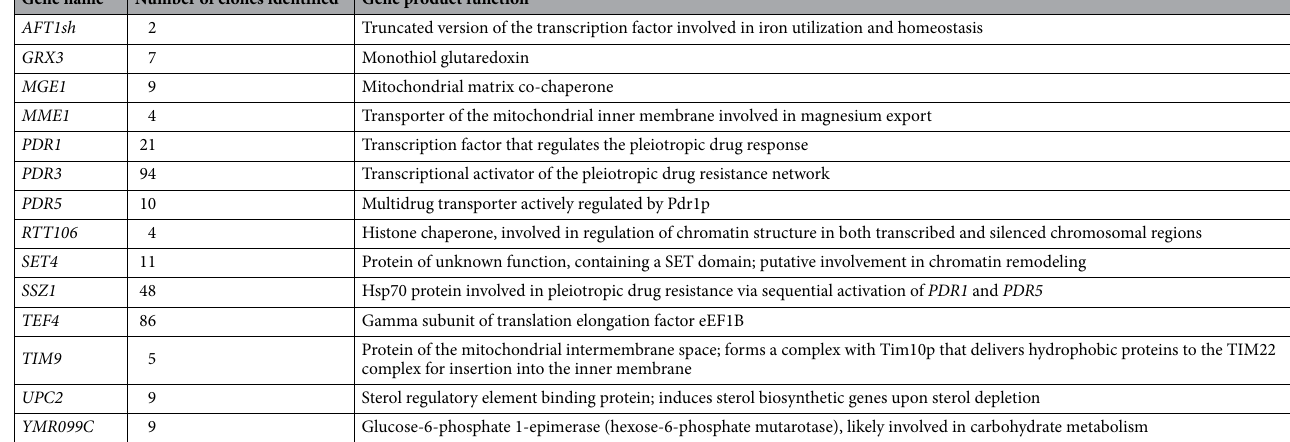
Table 2. Multicopy suppressors of Ni(S-tcitr) 2